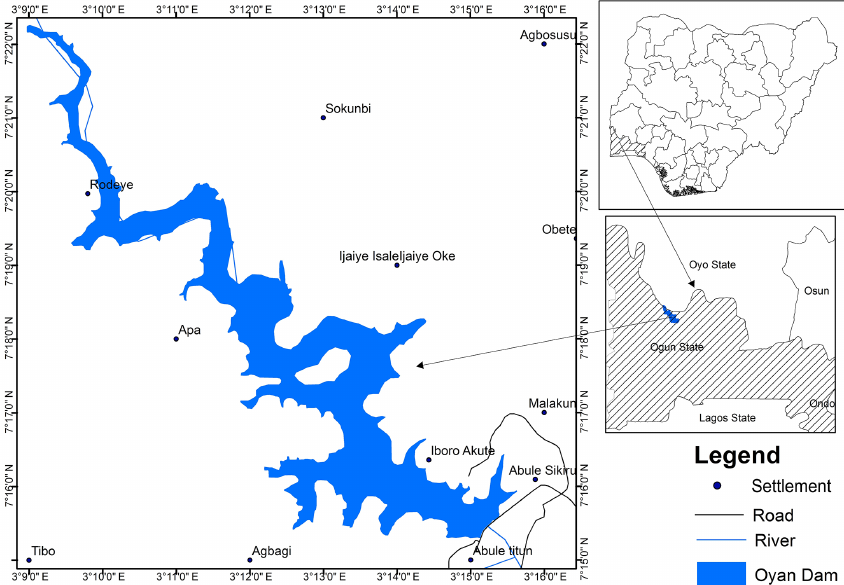
Figure 1. Oyan Dam (Insert – top right: Nigeria; Insert – bottom right: Ogun State).